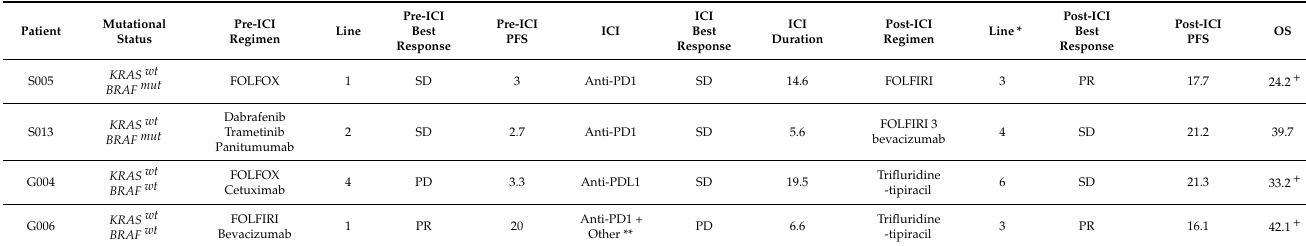
Table 4. Treatment regimens and outcomes of patients with long-lasting disease control (>12 months) on post-Immune Checkpoint Inhibitor(s) chemotherapy ± targeted